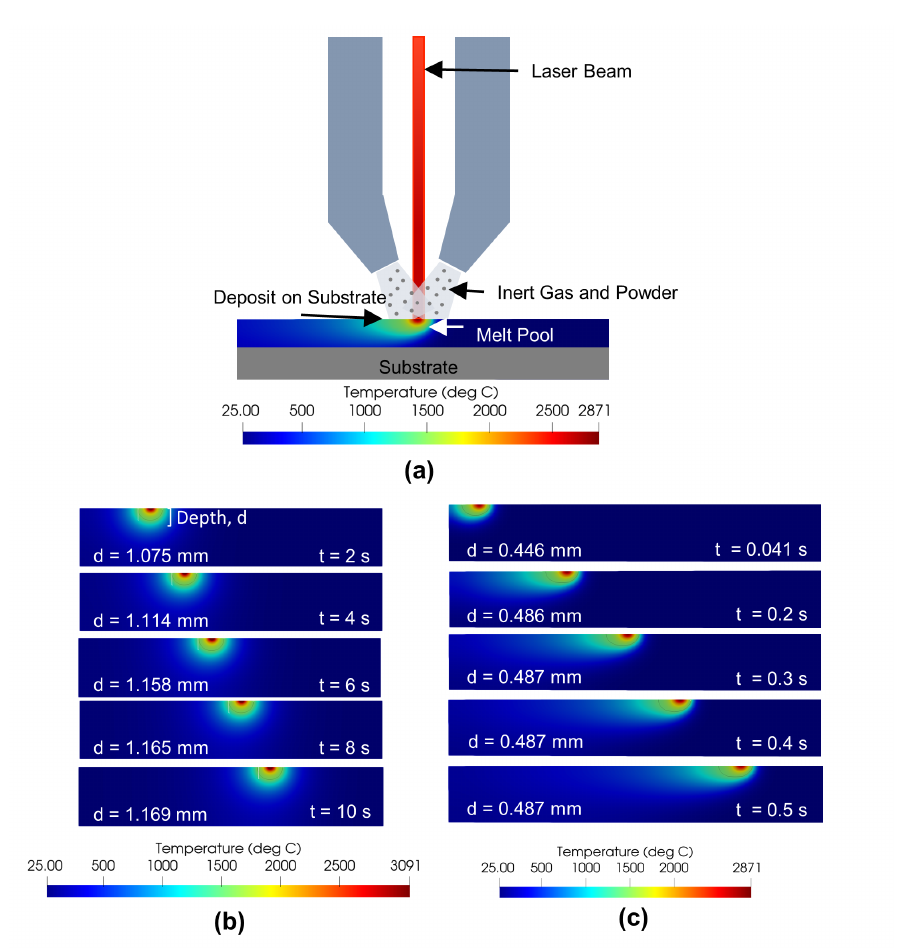
Figure 1. ( a ) A schematic of the L-DED process. ( b ) The melt pool evolution during the L-DED process for a representative power, P = 1000 W, and scan velocity, v = 1 mm/s showing a near-symmetric melt pool. ( c ) A second representative melt pool evolution at P = 1000 W, v = 25 mm/s showing the capability of Netfabb ® in capturing an asymmetric melt pool evolution. The melt pool reaches steady-state much earlier in ( c ) than ( b ) due to higher v